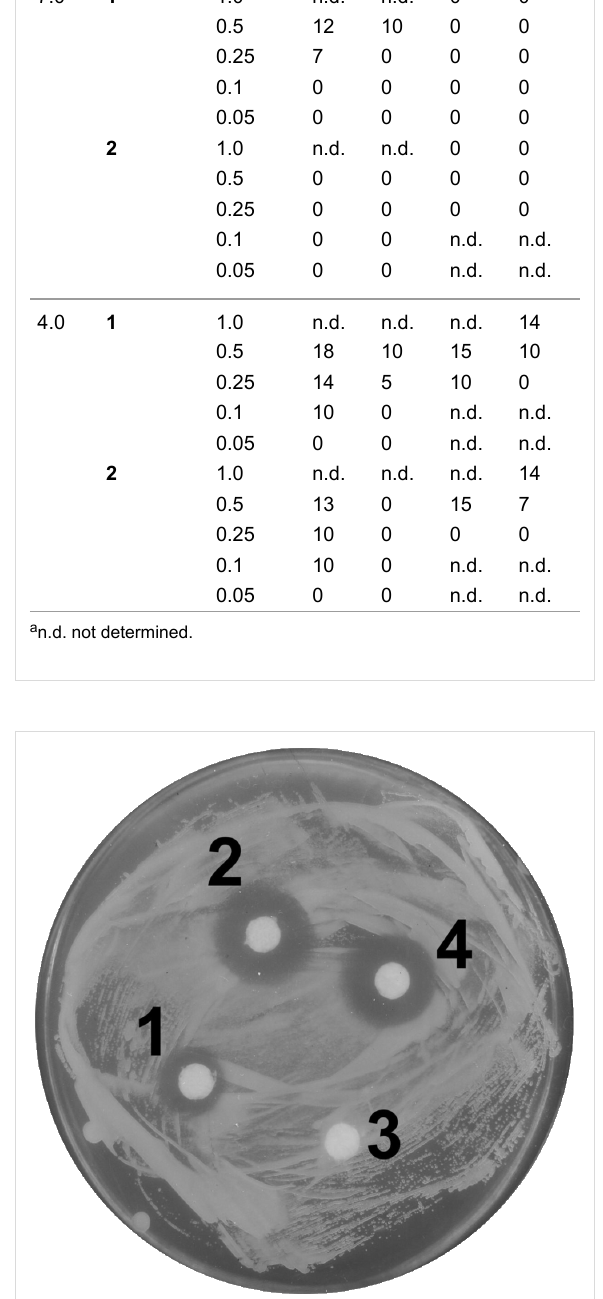
Figure 6: Growth inhibition zones for F. neoformans IGC 3957 in the presence of compounds 1 and 2 at pH 4.0. Compound 1 : (1) 0.25 mg/ disc, (2) 0.5 mg/disc; compound 2 : (3) 0.25 mg/disc, (4) 0.5